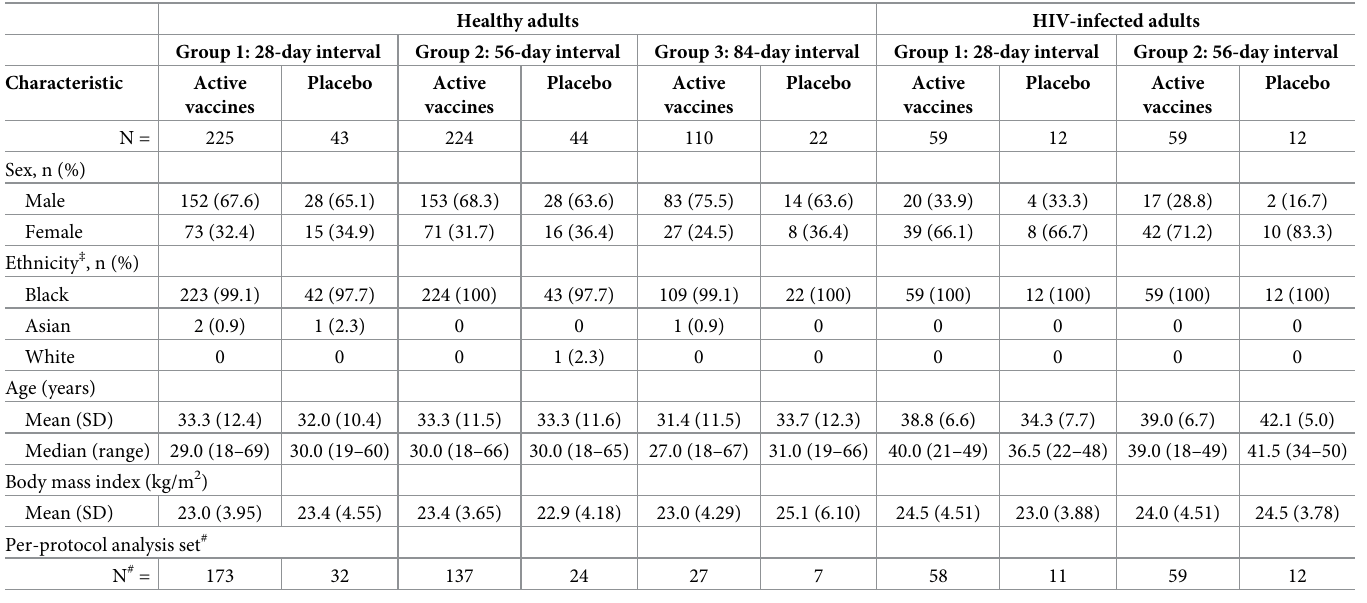
Table 1. Baseline characteristics of the participants in the full analysis set.